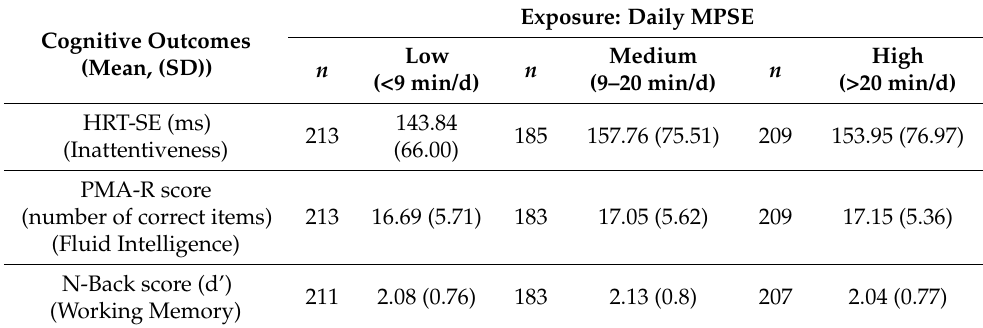
Table 2. Cognitive scores by mobile phone screen exposure